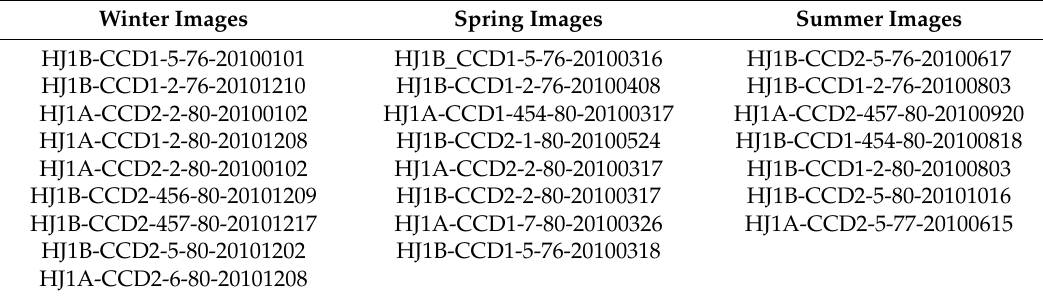
Table 2. HJ-CCD remote sensing images used in this